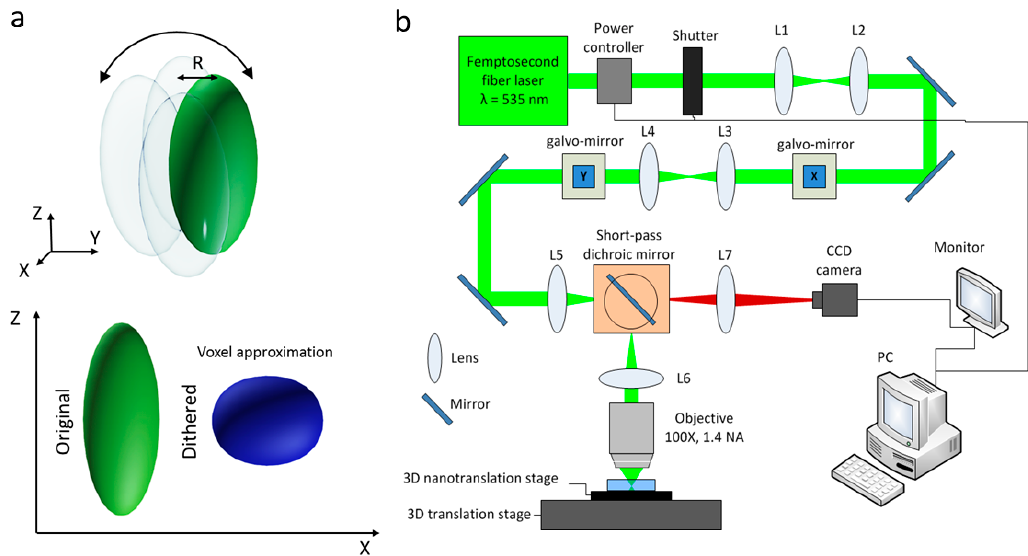
Figure 2. Galvo-dithered direct laser writing (GD-DLW) system. ( a ) Illustration of circular dithered correction applied by galvo-mirrors. Radius of the dithered correction, R, is comparable to the voxel resolution. This causes the fabrication voxel to become shorter in the Z direction, improving overall resolution of the 3D fabrication method and leading to correction of voxel asymmetry. ( b ) Schematic of the GD-DLW setup.